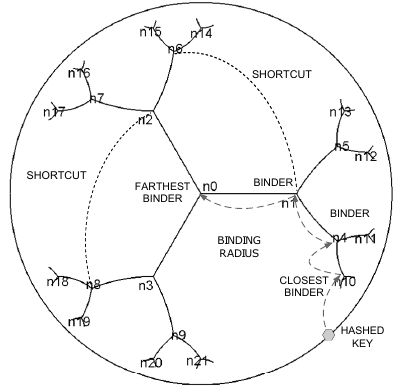
Figure 7. Hyperbolic DHT system.